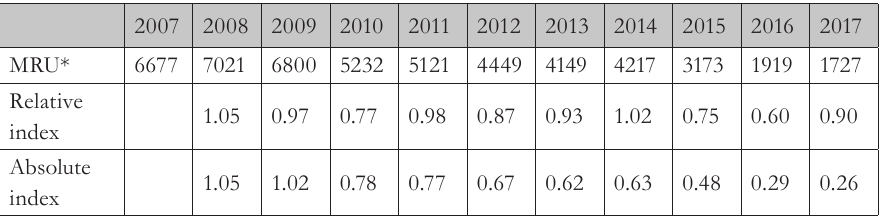
Tab. 2 – Lithuanian state budget appropriations in thousands of EUR. Source: Mykolas Romeris